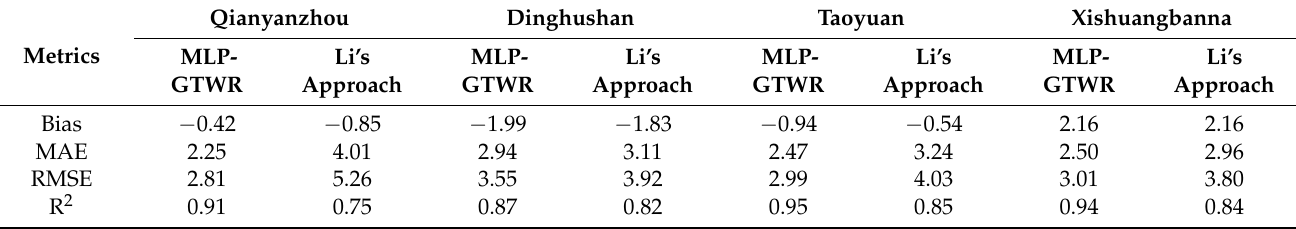
Table A2. Comparison of the MLP-GTWR LSTcor and the fused LST from MODIS data using Li’s method [19] against the in-situ measurements at four flux towers. The statistical metrics at each site are shown.